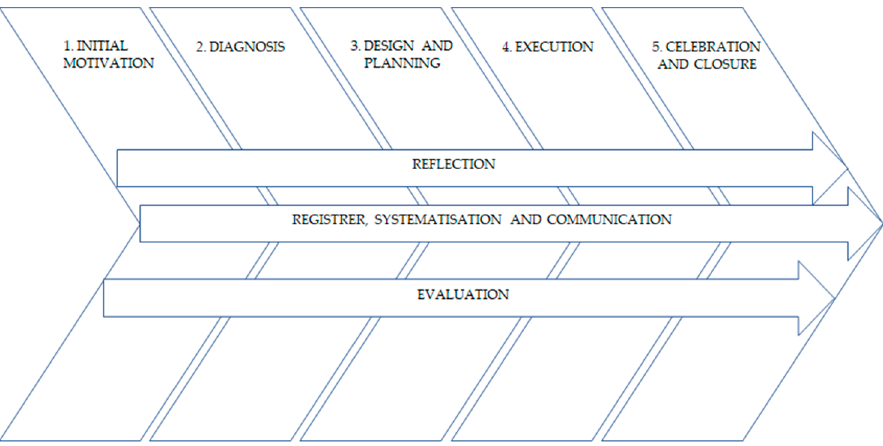
Figure 1. Phases of a Service-Learning Project. Source: model proposed by CLAYSS [40].